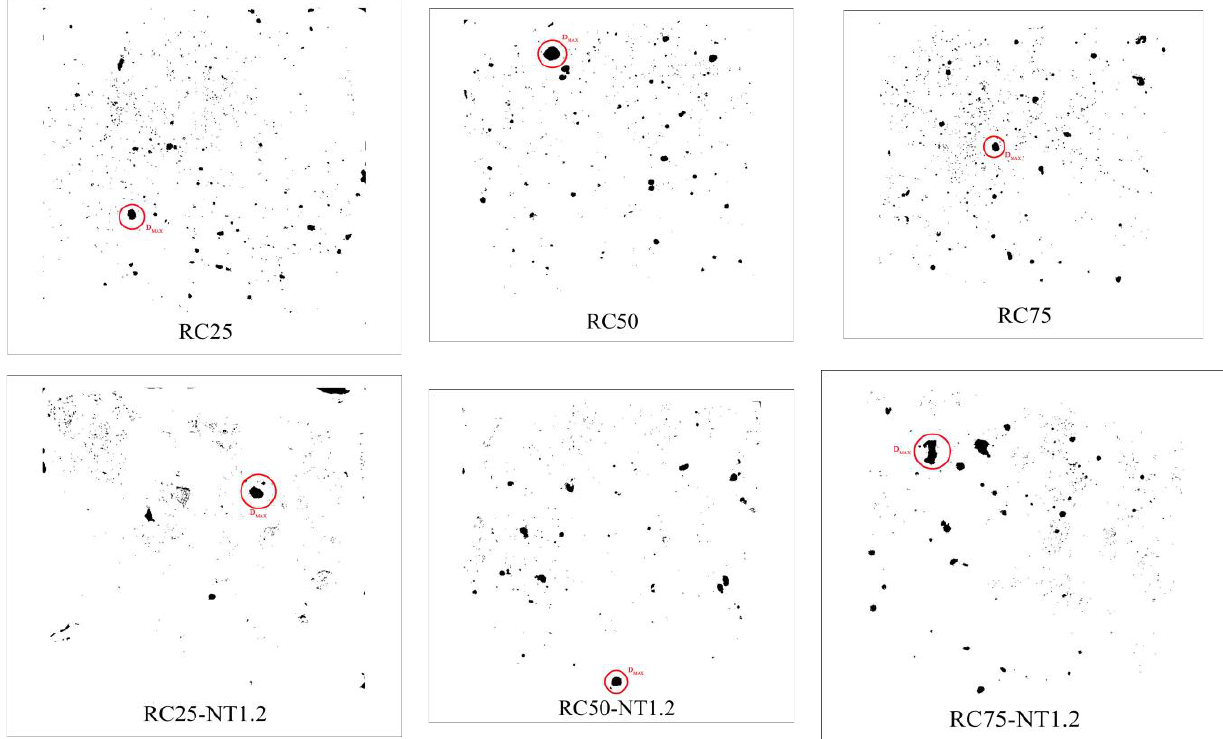
Figure 8. Macroscopic pore diagram of recycled aggregate concrete without freeze – thaw.